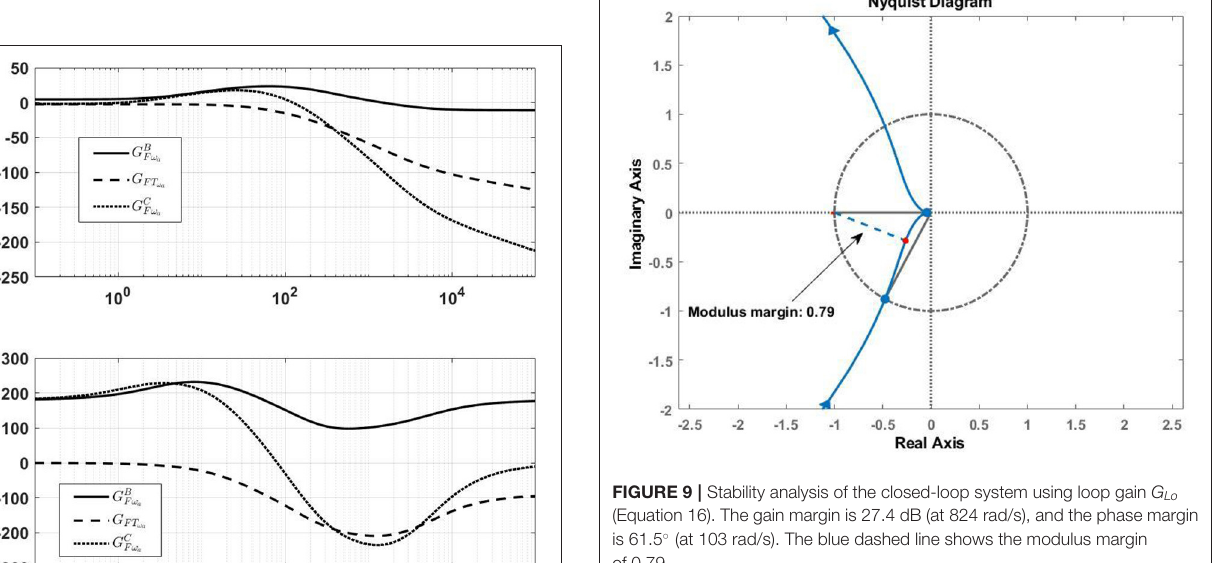
FIGURE 6 | Bode diagram of the transfer functions from the actuator control signal to the force output before ( G FT force-feedback lead controller, and also the transfer functions from the angular velocity of the actuator to the force output before ( G A F ω including the force-feedback lead controller.